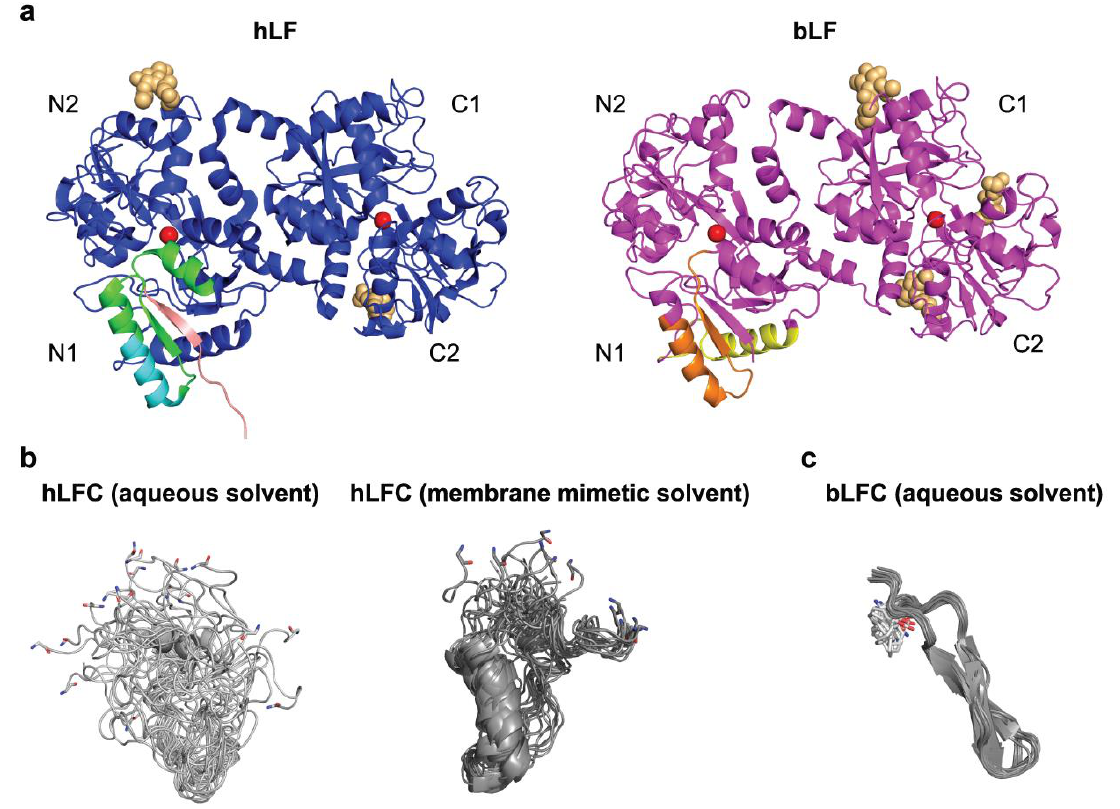
Figure 1. Domain architecture of human (hLF) and bovine (bLF) lactoferrin and the localization of the bioactive peptides within. ( a ) X-ray structures of holo-hLF (PDB ID 2BJJ, blue cartoon) and holo-bLF (PDB ID 1BLF, magenta cartoon). The positions of individual domains in the N- and C-lobes are indicated. hLFC (residues 1–49) is highlighted in different colors (green, salmon, and cyan) in the N1 domain of hLF. In particular, stretches of hLFC carrying a pronounced antimicrobial activity, often studied in the form of synthetic peptides (hLFC (residues 1–11) and hLFC (residues 21–31)), are shown in salmon and cyan, respectively. bLFC (residues 17–41) and bovine lactoferrampin (bLFA) (residues 265–284) are shown in orange and yellow, respectively, in the N1 domain of bLF. Iron ions bound to bLF and hLF are shown as red spheres. Note the differences in the glycosylation pattern of both proteins (asparagine and the first N-acetylglucosamine sugar residue are shown as beige spheres). ( b ) Twenty NMR solution structures of hLFC in aqueous solution (PDB ID 1Z6W) and in a membrane mimetic solvent (PDB ID 1Z6V). hLFC adopts a mostly disordered coiled conformation in aqueous solution. The flexibility of this conformation facilitates an adaptive binding to negatively charged surfaces of pathogen proteins. In a membrane mimetic solvent, the central part of hLFC acquires an amphipathic helical conformation, similar to the one it adopts in intact LF, thereby acting to disrupt pathogen membranes. ( c ) Twenty NMR solution structures of bLFC in aqueous solution (PDB ID 1LFC, gray). In contrast to the αβ conformation that retains the same residues in intact bLF (as shown in panel A ), the bLFC peptide has a strong tendency to form a distorted, amphipathic antiparallel β-sheet. The N-terminal glycine residues in ( b ) and the N-termi- nal phenylalanine residues in ( c ) are highlighted as sticks; with carbon, nitrogen, and oxygen atoms labeled in grey, blue, and red, respectively. All structures were generated using PyMOL software.